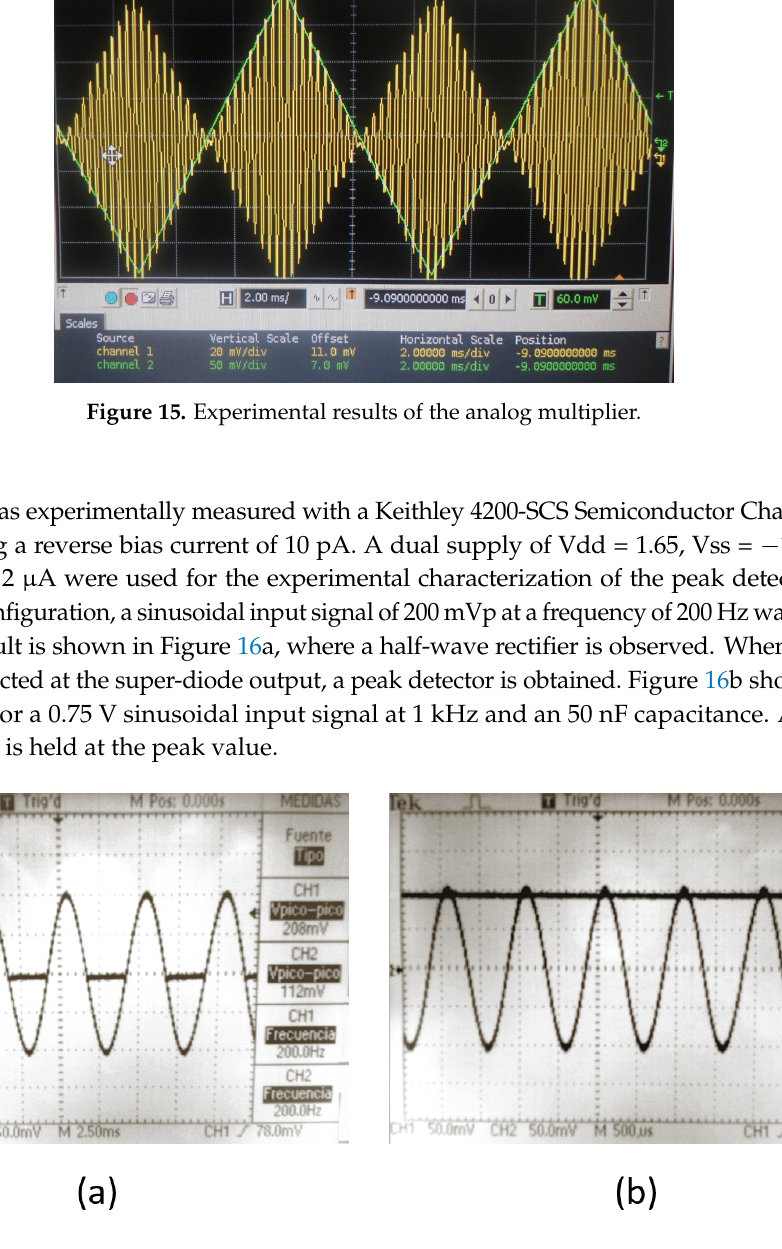
Figure 16. Experimental results of the peak detector: ( a ) half-wave rectifier and ( b ) peak